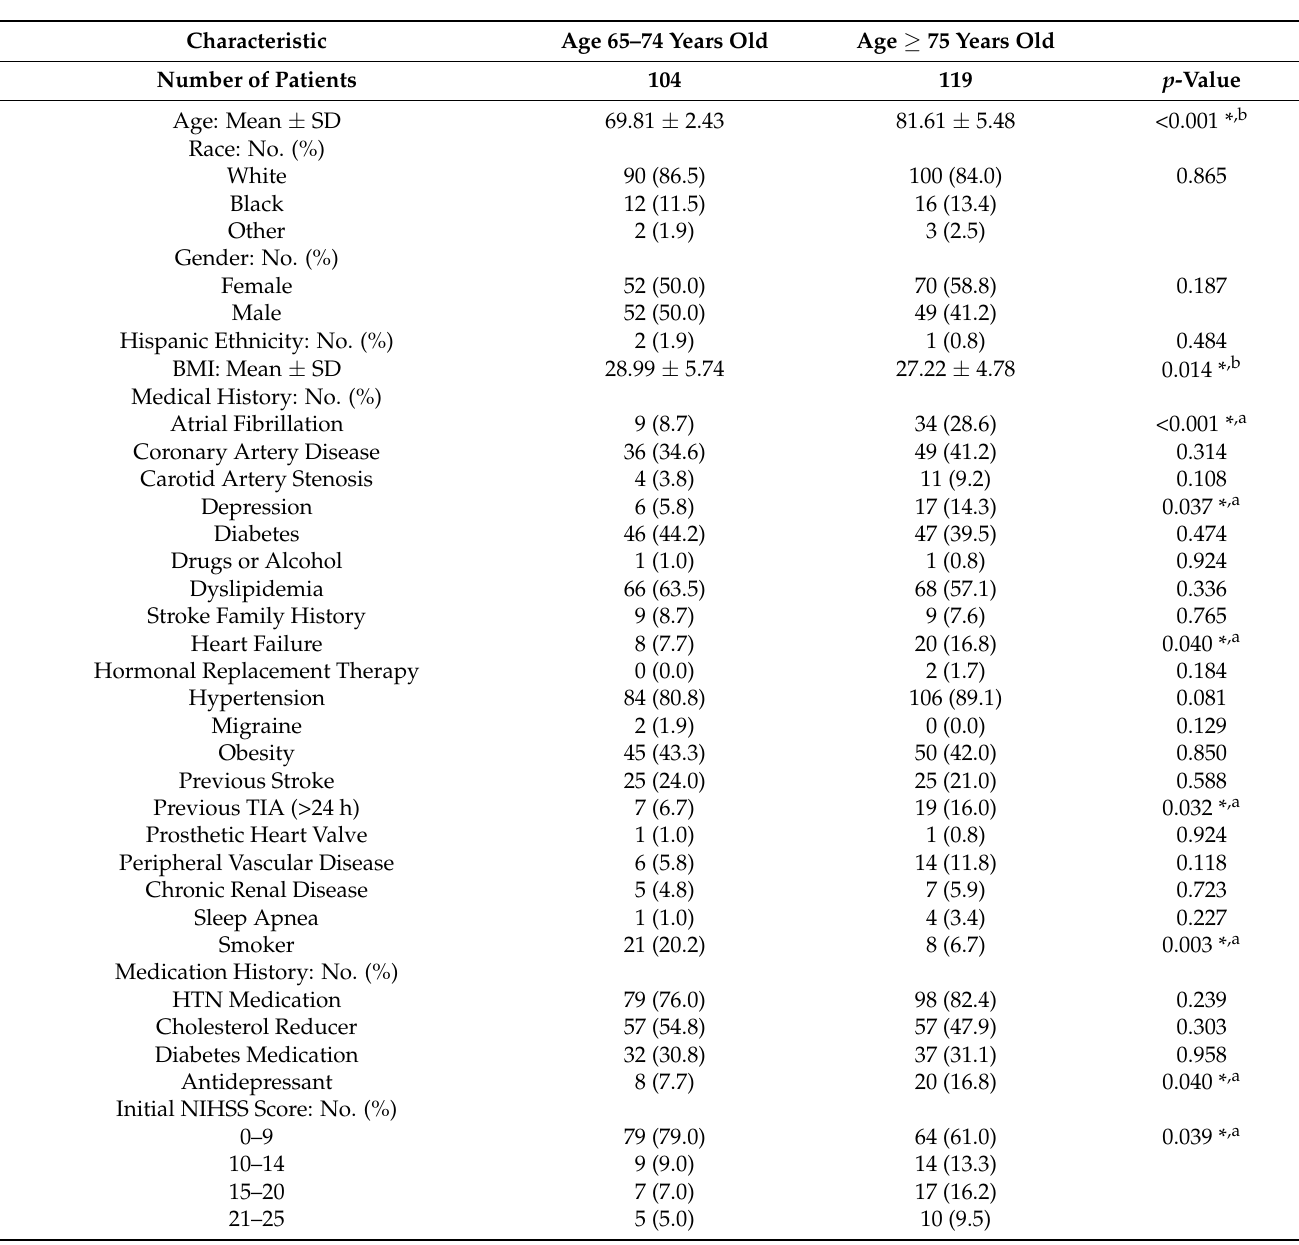
Table 1. Comparison of demographics and clinical characteristics of acute ischemic stroke patients in the telestroke database. Demographic and clinical characteristics of ischemic stroke patients were divided by age (65–74 years or ≥ 75 years old). Results for continuous variables are presented as means ± SDs, while discrete data are presented as percentage frequencies. Pearson’s chi-square test was used to compare differences between demographic and clinical characteristics in 65–74-year-old and ≥ 75-year-old